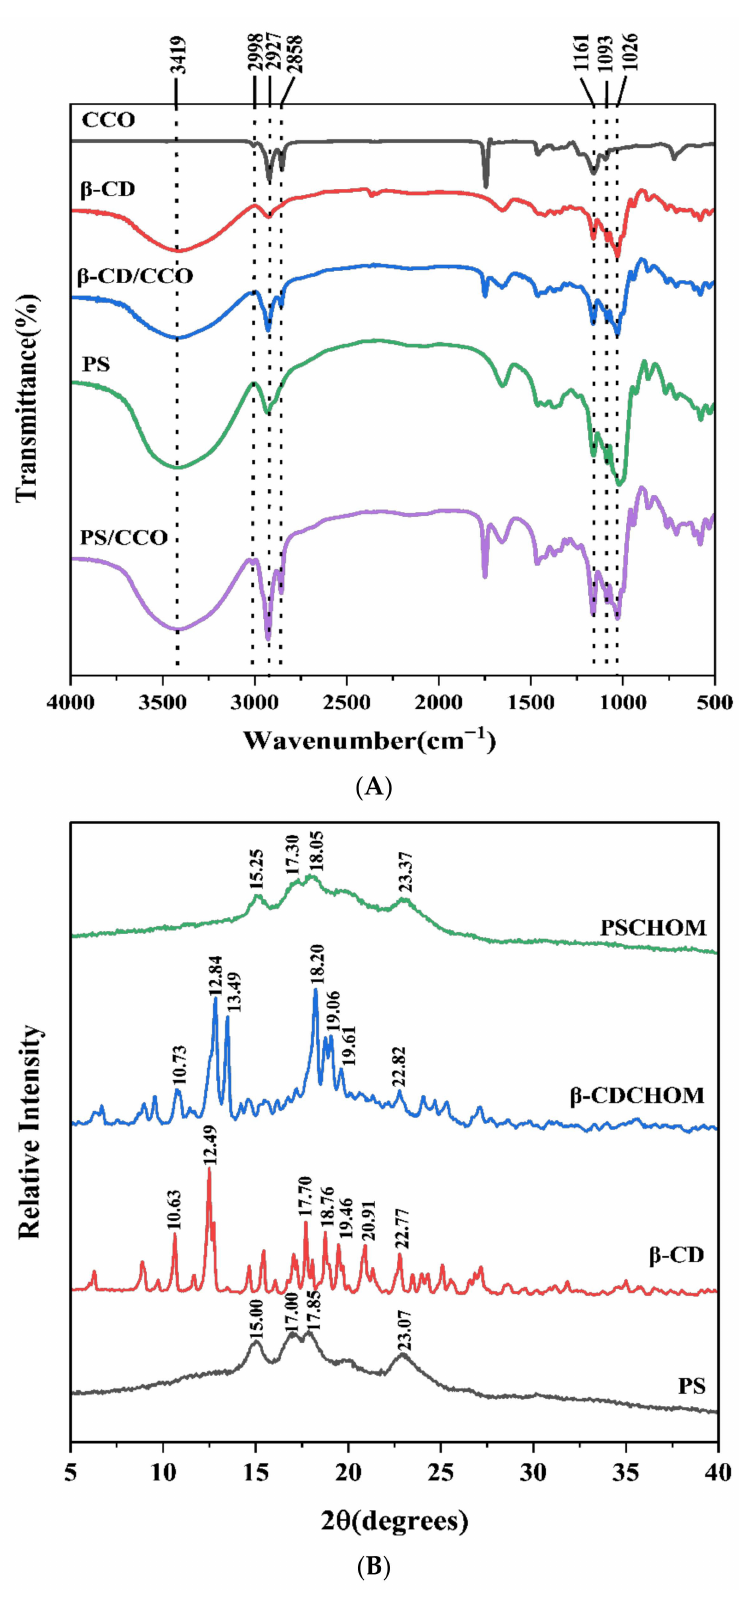
Figure 2. FT-IR spectra ( A ) and XRD spectrograms ( B ) of β -CD, PS and their CHO microcapsules. β -CD, β -Cyclodextrin; PS, Porous starch; CHO, cold-pressed hickory oil; β -CDCHOM, β -cyclodextrin cold-pressed hickory oil microcapsule; PSCHOM, Porous starch cold-pressed hickory oil